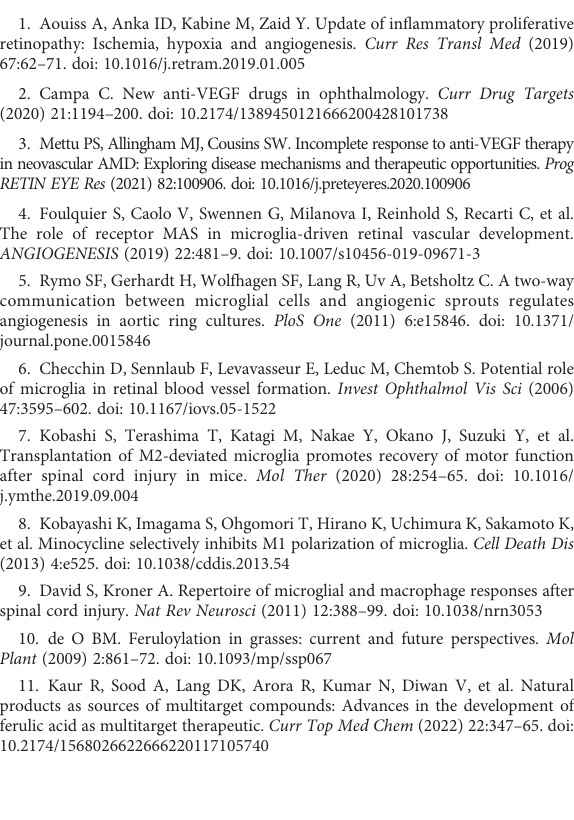
SUPPLEMENTARY FIGURE 1 Establishment of the Oxygen-induced retinopathy (OIR) murine model. Mouse pups wereexposed to 75% oxygen from postnatal day 7 (P7) to P12 using an Oxy Cycler system and then returned to room air. Retinas at differenttimepoints (P12, P13,P14, P15, P16, P17, P21,P25) werecollected, stained with Isolectin B4, and fl at-mounted. The images were obtained usingamicroscope(LeicaDM4000,Germany).Non-OIRretinas(P12,P17) was used as a control. SUPPLEMENTARY FIGURE 2 qRT-PCR analysis of proangiogenic factors and HIF-1 a in the OIR retinas. Note that the mRNA levels of VEGF, FGF2, PDGF-A, and HIF-1 a were up- regulated in the OIR retinas. FA treatment down-regulated VEGF level but had no impact on other molecules. Data are presented as mean ± SEM. * P < 0.05, ** P < 0.01, ns, no signi fi